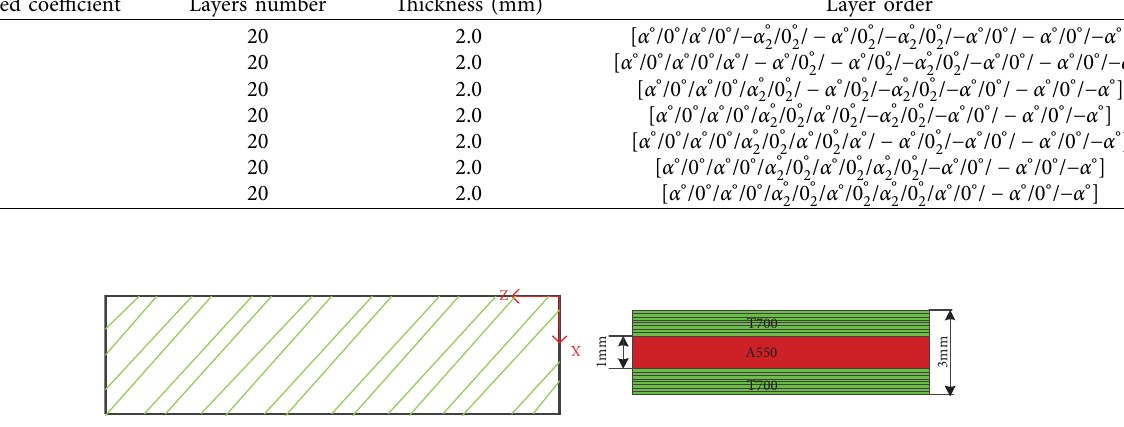
Figure 4: Model geometric parameters and layering reference direction